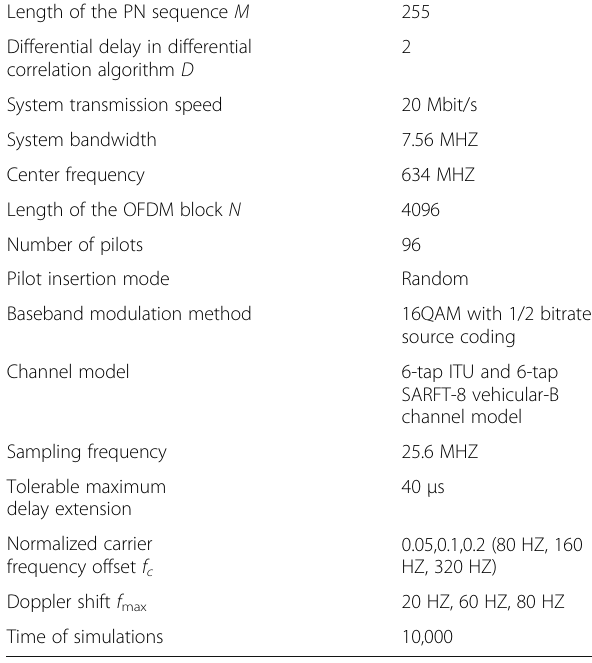
Table 1 Parameters in the simulations